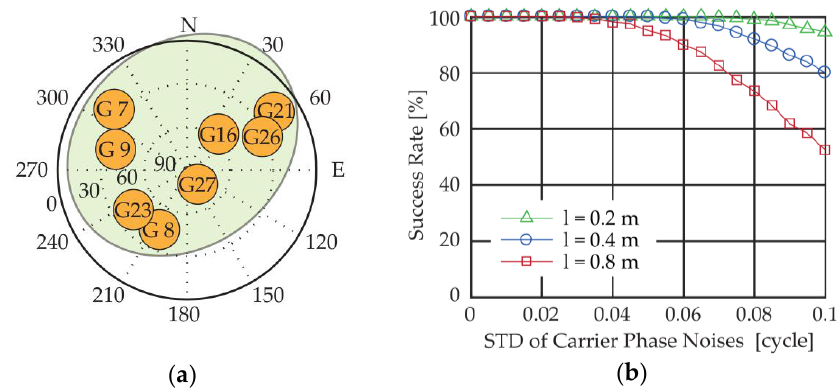
Figure 5. ( a ) Satellite geometry distribution; ( b ) Success rates of the MSR method under (a).